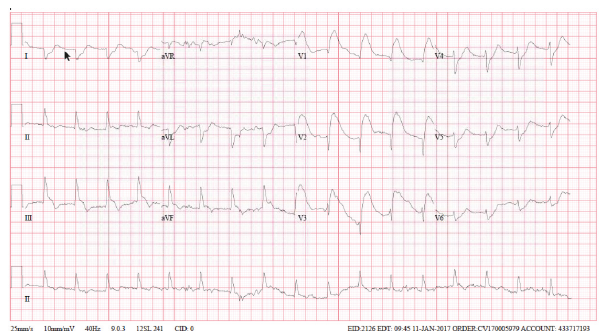
Figure 1: Acute pulmonary embolism presenting with STEMI-like ECG